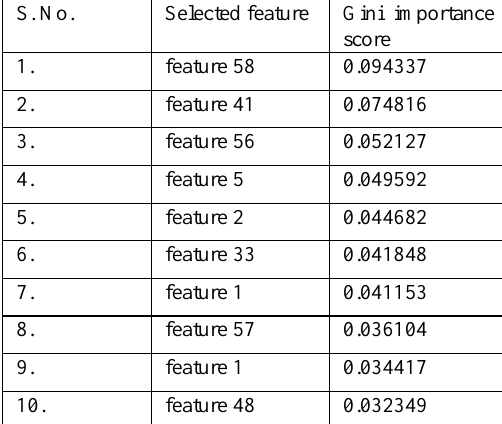
Table 3. Best features having highest Gini importance score